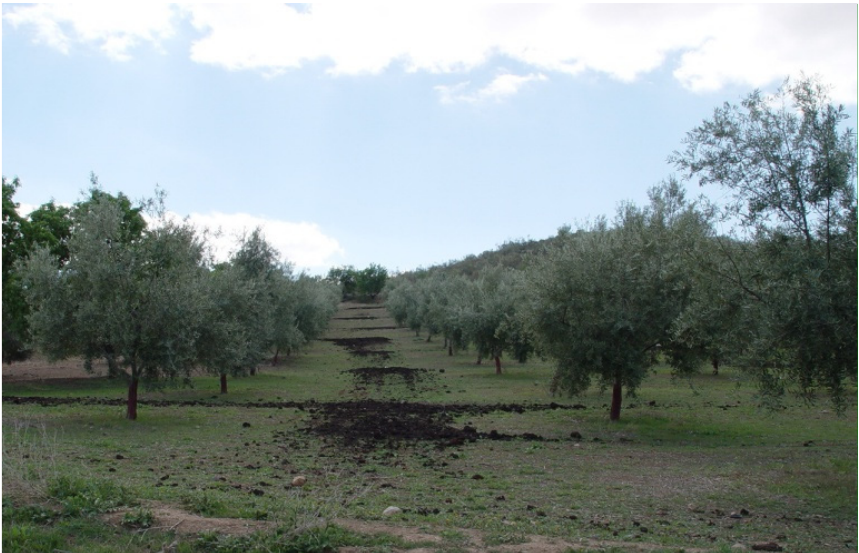
Figure 10. Ecological fertilisation with fertilisers in the form of crop residues and manure.